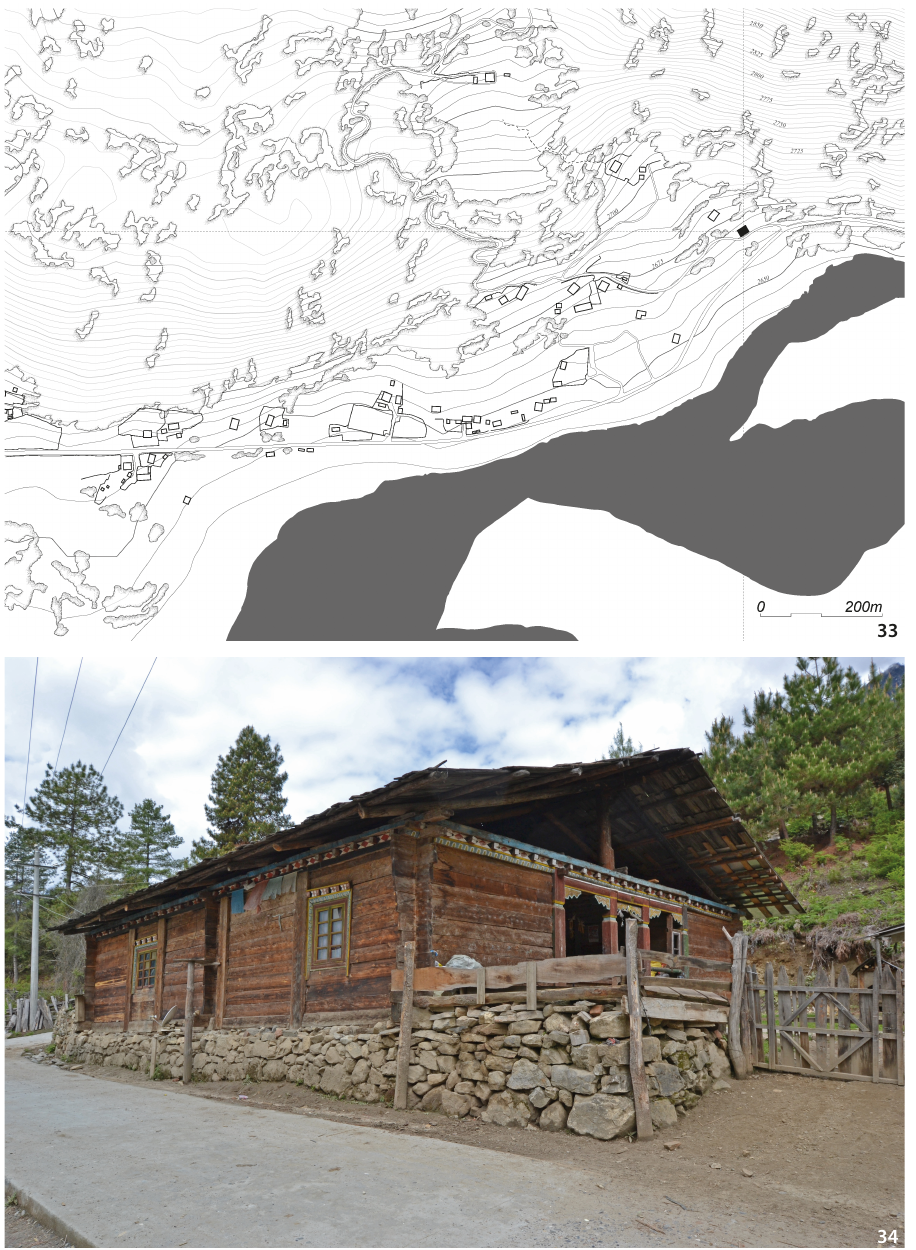
Figure 33 Site plan of the farm- house in Pome (Source: the au- thors). Figure 34 Southeast and north- east view of the farmhouse in Pome (Source: the